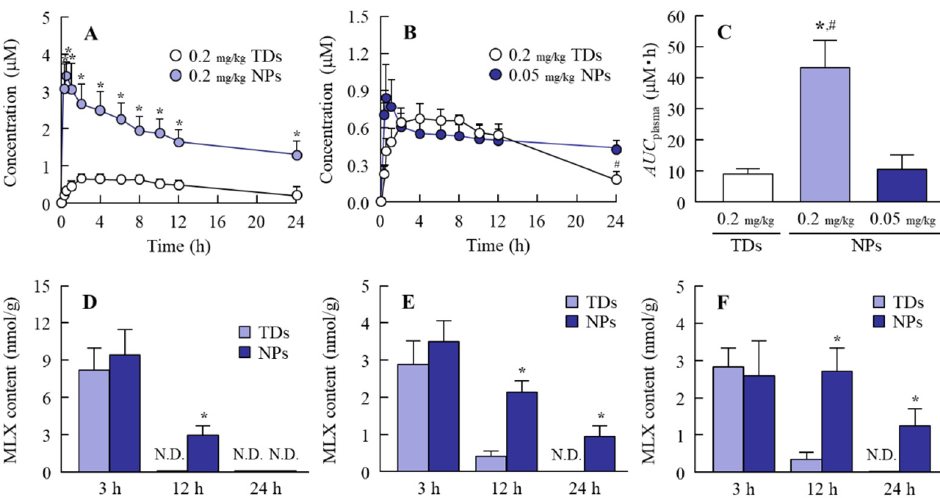
Figure 5. Di ff erences in the MLX absorption profiles in rats orally administered MLX-TDs or Figure 5. Differences in the MLX absorption profiles in rats orally administered MLX-TDs or MLX-